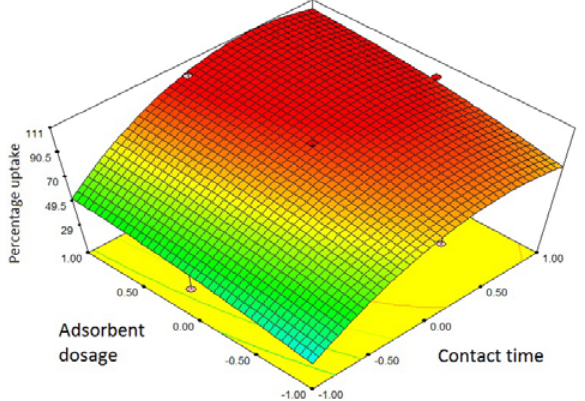
Figure 10. 3D surface plot for uptake of MB as a function of adsor- bent dosage and contact time.